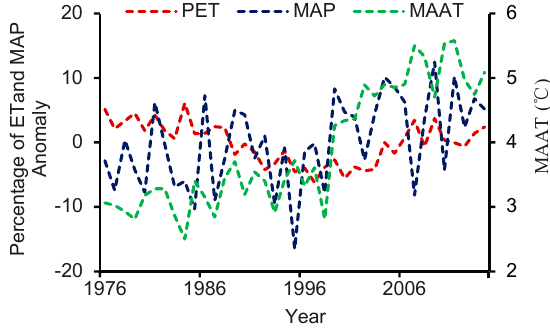
Figure 4. Annual changes in PET, MAP, and MAAT on the Tibetan Plateau between 1977 and 2014.